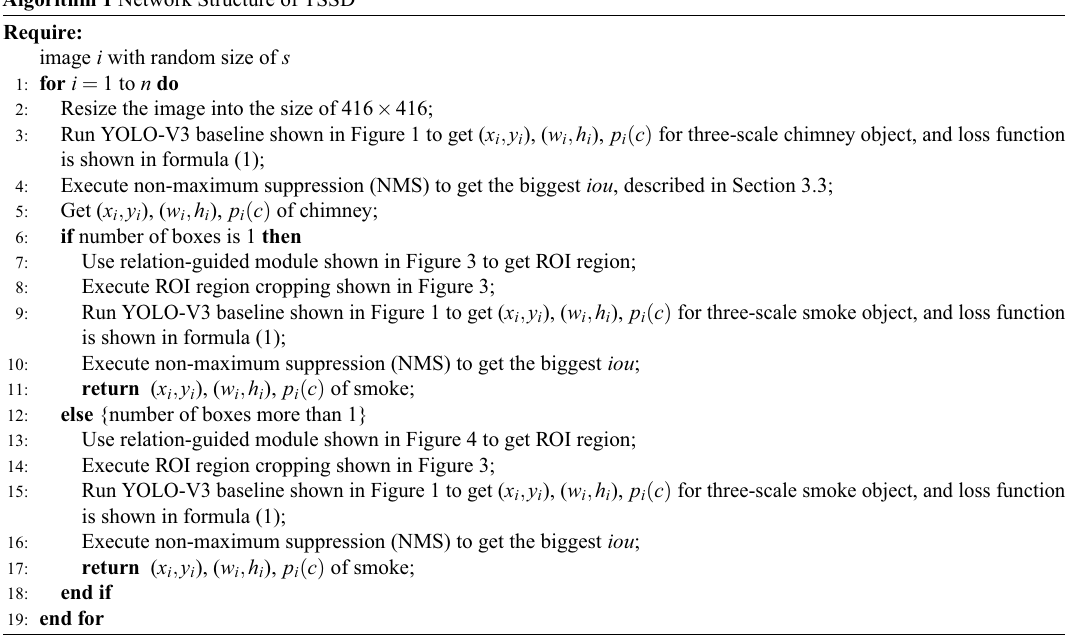
Algorithm 1 Network Structure of TSSD